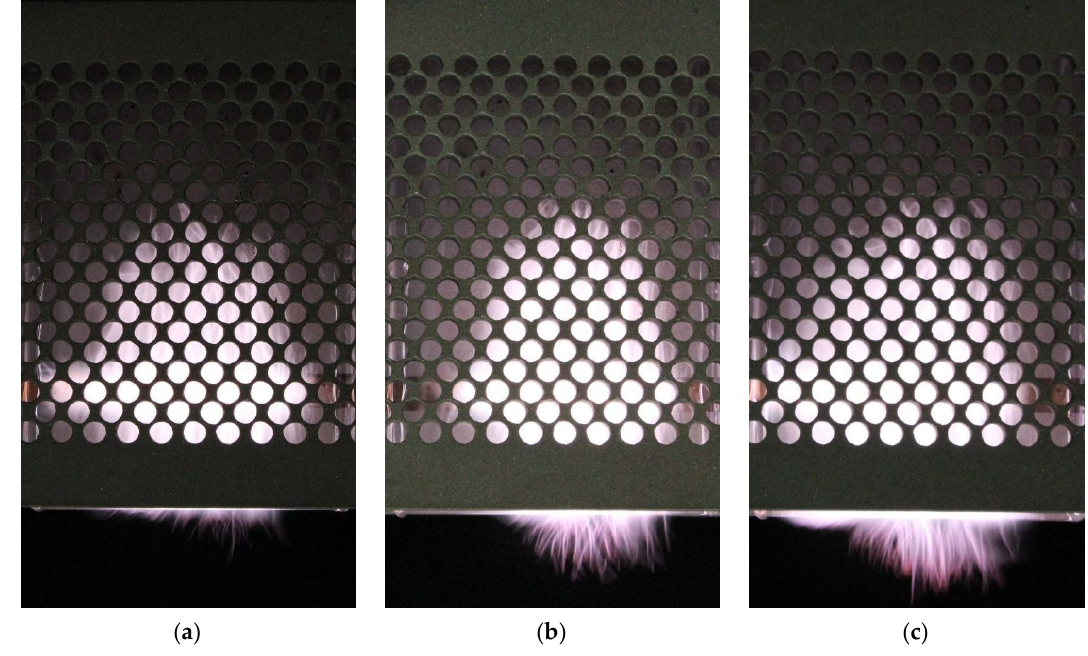
Figure 21. Plasma visualization for: ( a ) open ( P ref / P inc = 25%), ( b ) semi-closed ( P ref / P inc = 15%), and ( c ) closed ( P ref / P inc = 40%) configuration. Microwave power entering the MPSS is 250 W, argon flow rate 15 L/min.